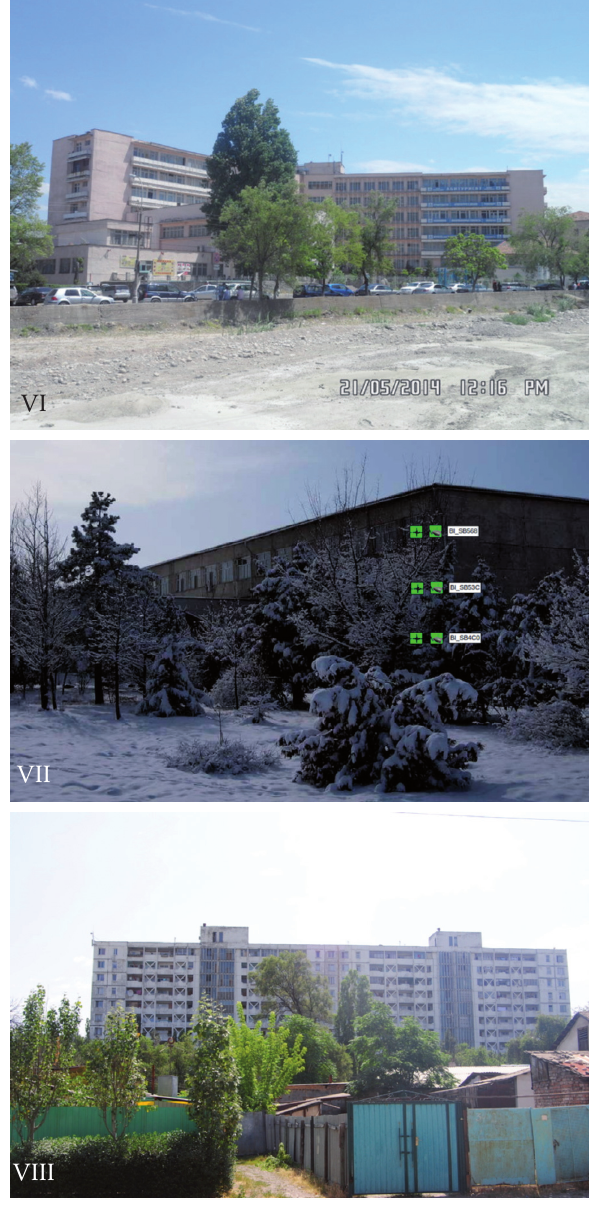
Figure 8. Photos of the 3 monitored buildings in Bishkek. (VI) KSUCTA, (VII) KIS and (VIII) 12 story RC building